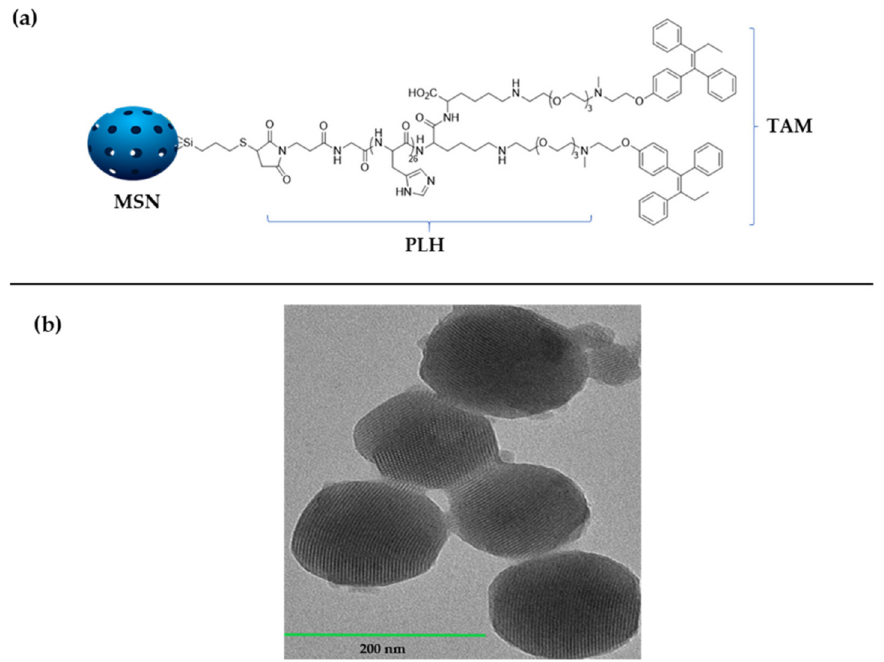
Figure 1. ( a ) The triple-action nanostructure DDS based on MSNs, functionalized with the pH sensitive PLH polymer and the hormonal drug Tamoxifen. Image adapted from Day et al. [16]. ( b ) TEM images demonstrating the diameter and internal structure of MSNs on the 200 nm scale-bar, demonstrating well-defined ordered long-range structure of inner mesopores and highly ordered porous channels.